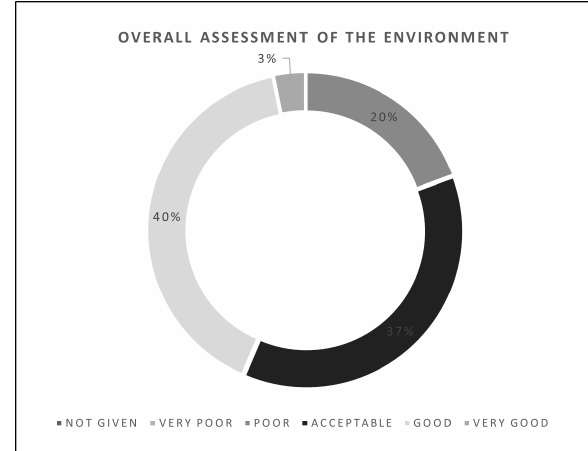
ately” appropriate to the context by almost half of the sub- jects (48%) followed by the 32% who defined it as “very” pertinent (Figure 12).